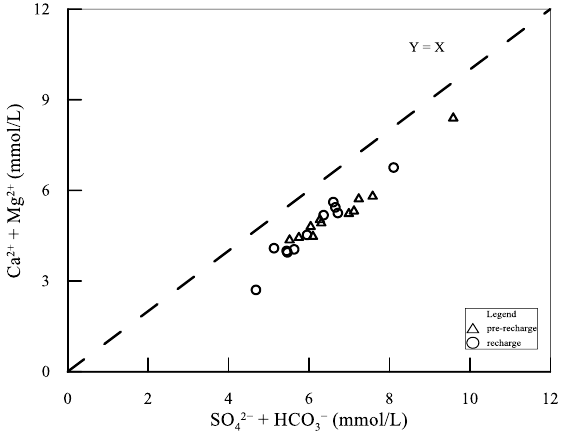
Figure 6. Scatter plot of the correlation between SO 4 2− + HCO 3 − and Ca 2+ + Mg 2+ . Chloro-alkaline indices (CAI) can be used to characterize the strength of ion exchange during the chemical evolution of groundwater [52], with the expressions R7 and R8. A negative index means Ca 2+ or Mg 2+ in groundwater is ion-exchanged with Na + in the aqueous medium. If the ratio is positive, then Na + in groundwater is ion-exchanged with Ca 2+ or Mg 2+ in the aqueous medium. The magnitude of the absolute value of the chlor-alkali index can also characterize the strength of the ion